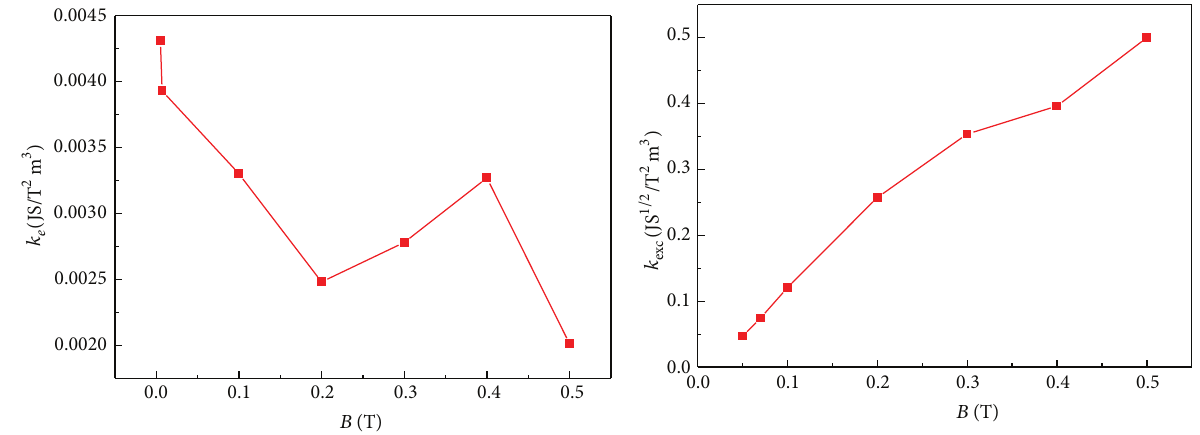
Figure 10: Variation of eddy current and excess loss coefficients ( 𝑘 𝑒 and 𝑘